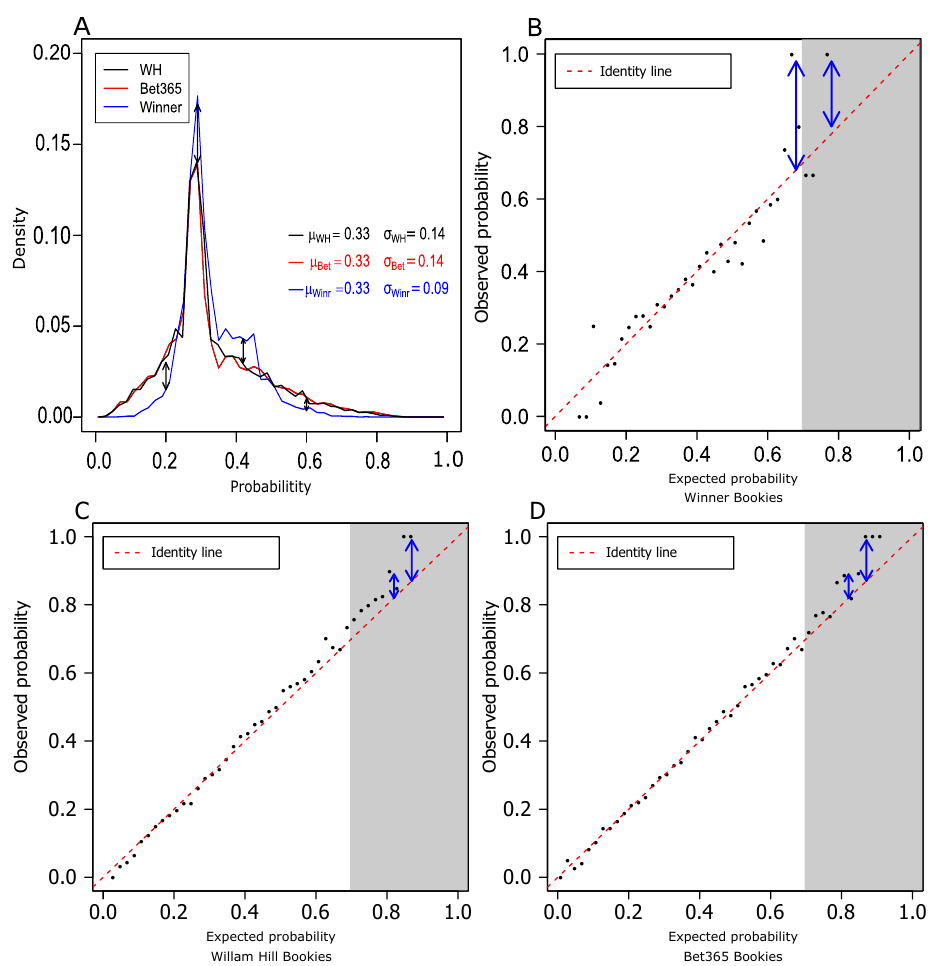
Figure 1. Assessing market efficiency for single bets. ( A ) Density curves of the betting probabilities for the three betting houses considered in this work: William Hill (WH), Bet365, and WINNER. The x-axis shows the expected probability for a single bet. The y-axis reflects the associated densities of these probabilities. ( B – D ) Single bet observed probability vs. the matching expected probability for WINNER ( B ), William Hill ( C ), and Bet365 ( D ). Each point in the plots corresponds to a set of bets in a range of expected probabilities (x-axis). The y-axis was calculated from the obtained results of these